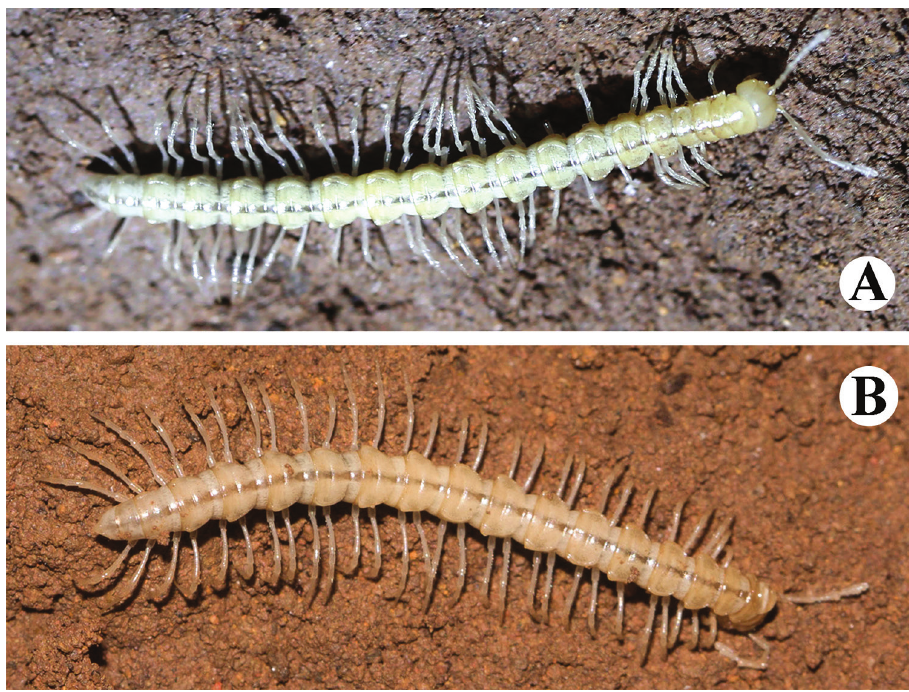
Figure 4. Tonkinosoma tiani sp. n. in nature A, B two different ♂